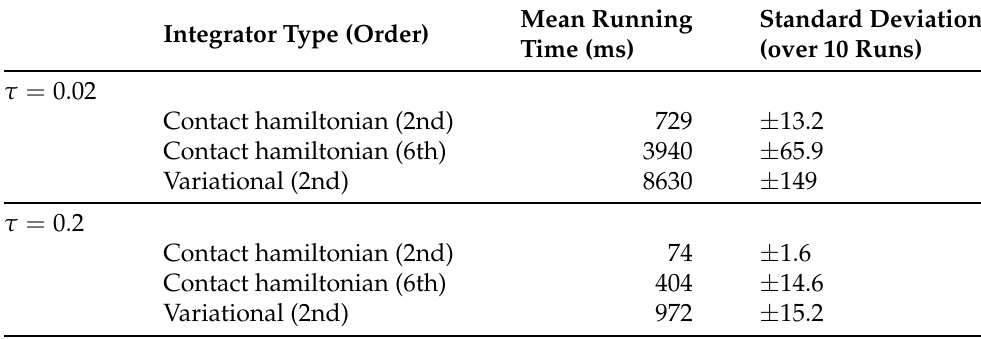
Table 2. Execution time statistics for the integration of a van der Pol oscillator with initial conditions ( q ) = ( 2,0,0 ) , (cid:101) = 3.5 for t ∈ [ 0,1000 ] . 0 , p 0 , s 0 Integrator Type